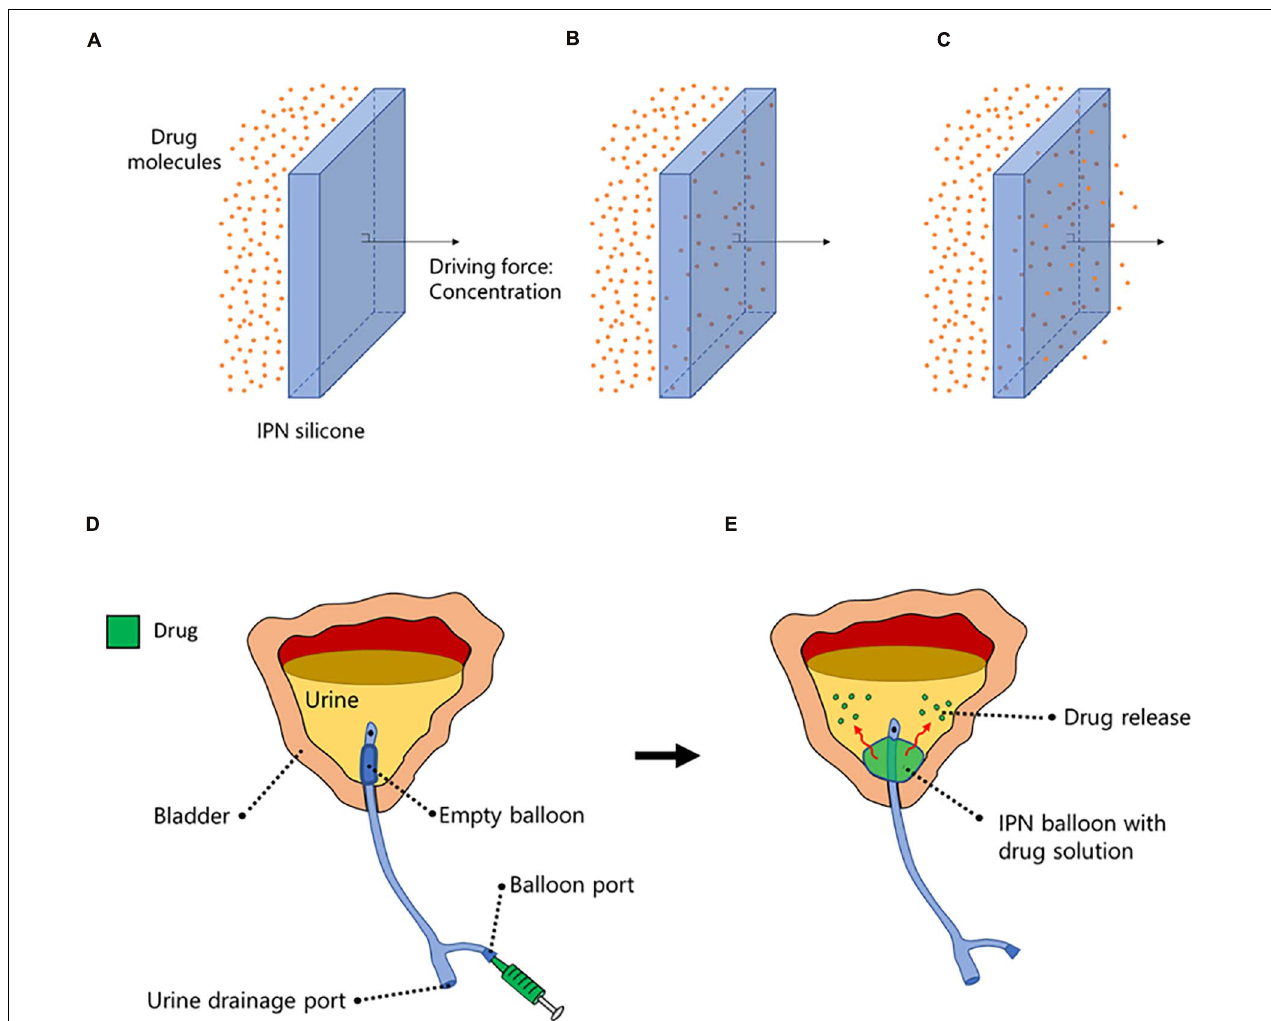
FIGURE 1 | A conceptual schematic. (A–C) The interpenetrating polymer network (IPN)-silicone facilitates concentration-dependent drug molecule migration from one side of the material to the other. (D) When implemented into a Foley-type catheter balloon, the balloon is inflated with a drug solution through the balloon port. (E) Once inflated, the balloon provides dual functionality by (i) ensuring anchorage of the catheter within the bladder and (ii) providing a drug reservoir capacity for controlled drug-release into the urine.